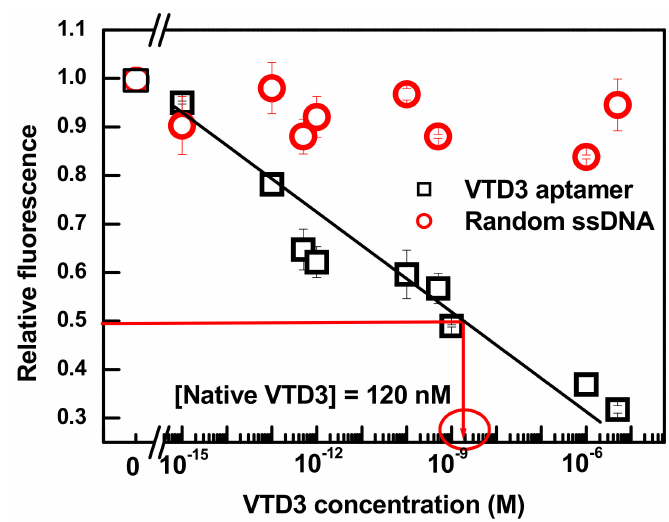
Figure 4. Di ff erential change in fluorescence (relative fluorescence) vs. concentration of VTD3 extracted from whole blood sample. The response towards VTD3 is also shown for a control experiment by replacing VTD3 aptamer with a random 70-mer aptamer. The concentrations of VTD3 aptamer and curcumin are 100 nM and 0.6 µ M, respectively. Error bars represent standard deviations from two